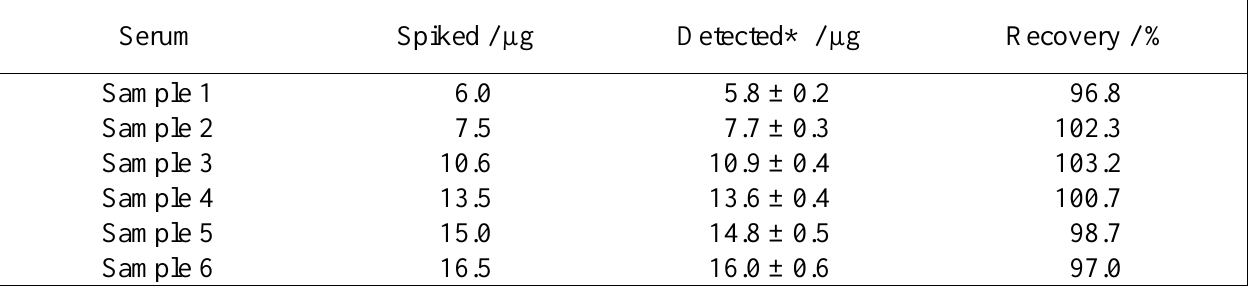
* Number of sample assayed was